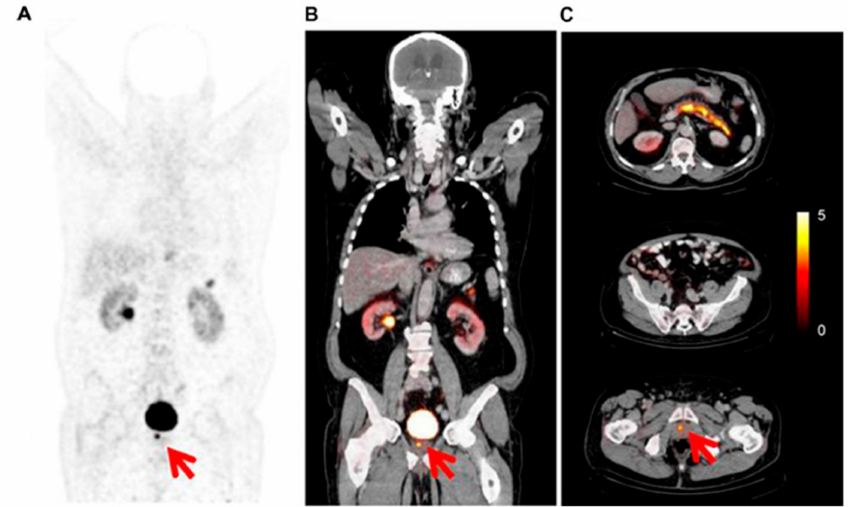
Figure 4. PET/CT GRPRs or bombesin-receptor imaging with 64 Cu-CB-TE2A-AR06, showing focal uptake of primary prostate cancer (red arrows), below urinary bladder activity, as shown by PET emissive coronal image ( A ), fused corresponding coronal ( B ) and axial slices ( C ) (Copyright © 2021. Wieser, Mansi, Grosu, et al. Positron emission tomography (PET) imaging of prostate cancer with a gastrin releasing peptide receptor antagonist—from mice to men. Theranostics. 2014;